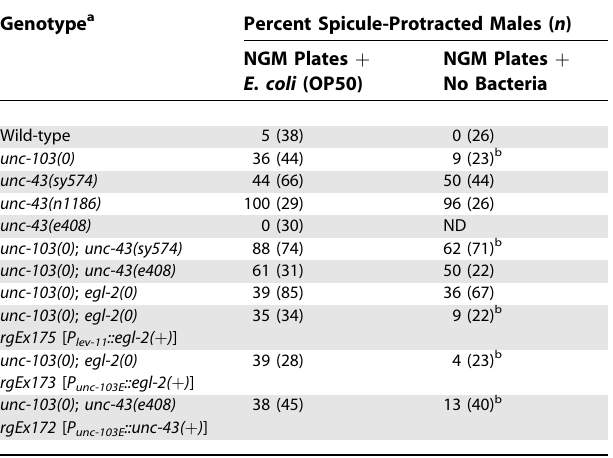
Table 4. Food Availability Modifies the Expressivity of Abnormal Spicule